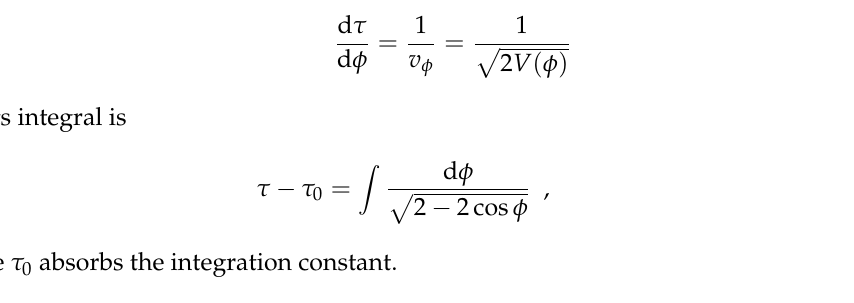
Table 1. The equations of the two pendulum models rewritten after the introduction of small parameter (cid:101) . The tilde is neglected in further notation.